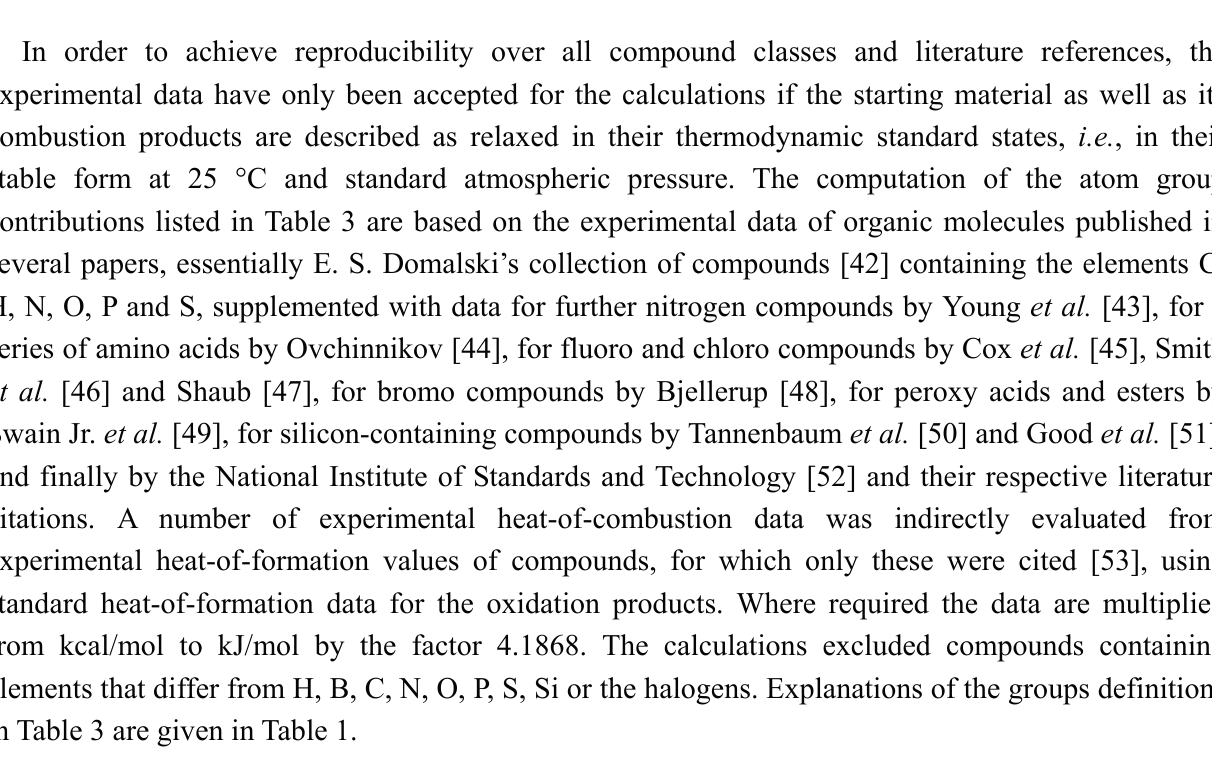
Table 3. Atom groups and their Contributions (in kJ/mol) for Heat-of-Combustion Calculations.